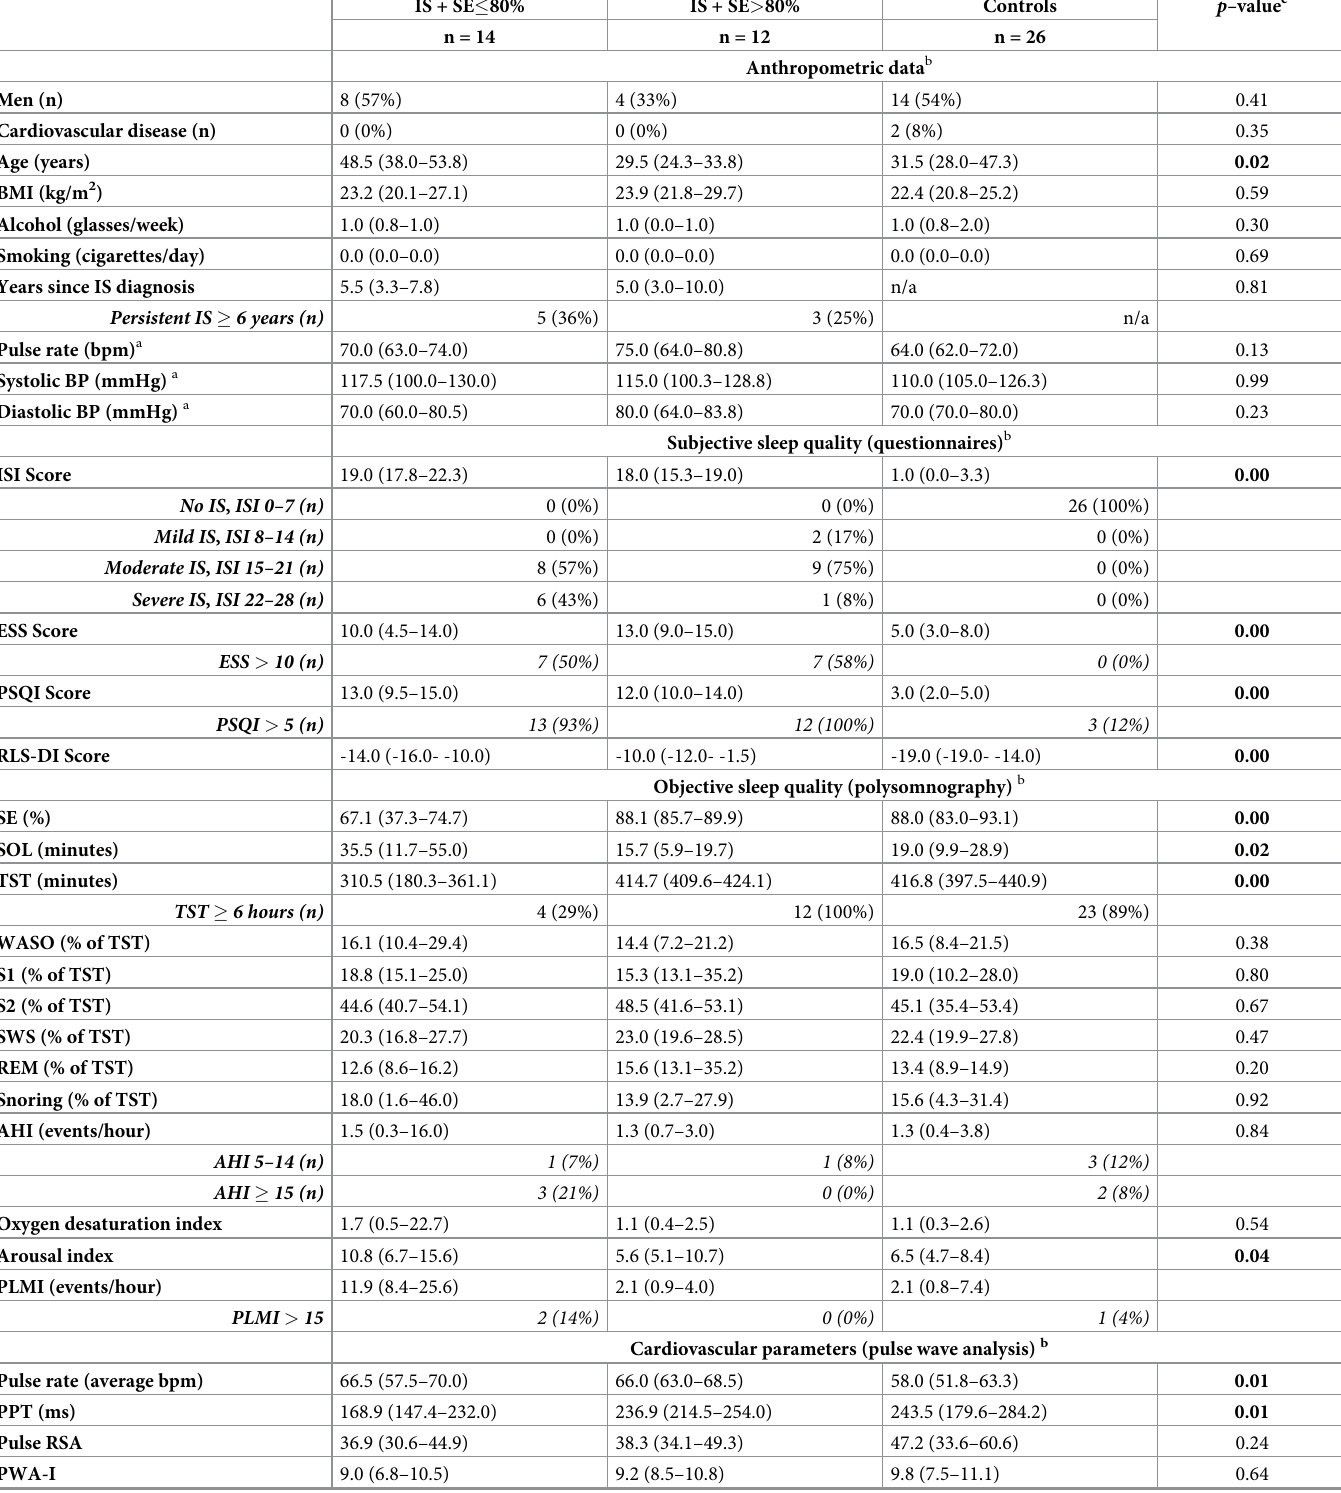
Table 1. Sample description including polysomnography and pulse wave analysis